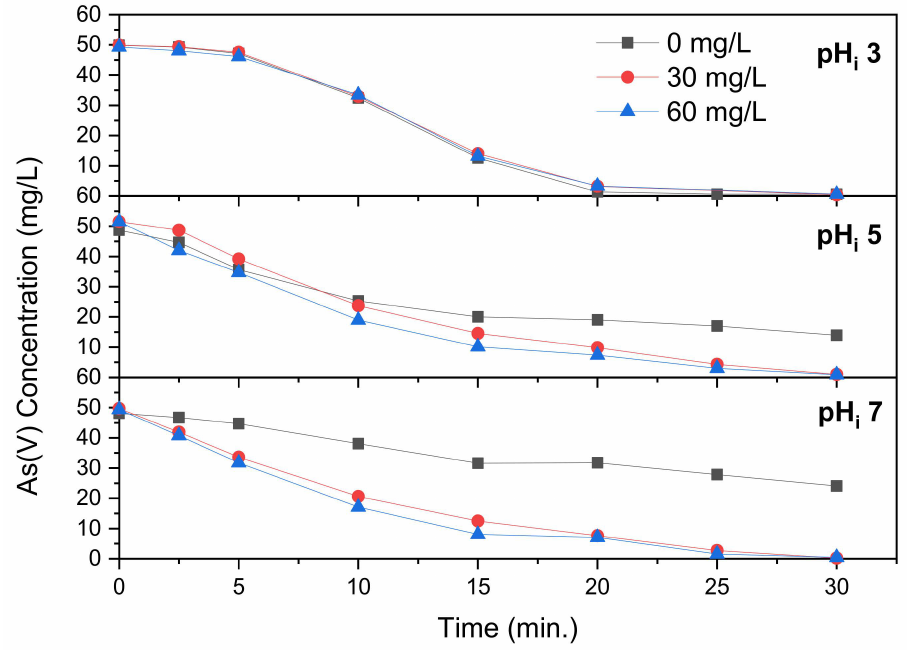
Figure 8. Arsenic removal over time through electrocoagulation assisted by varying concentrations of Mg(II)